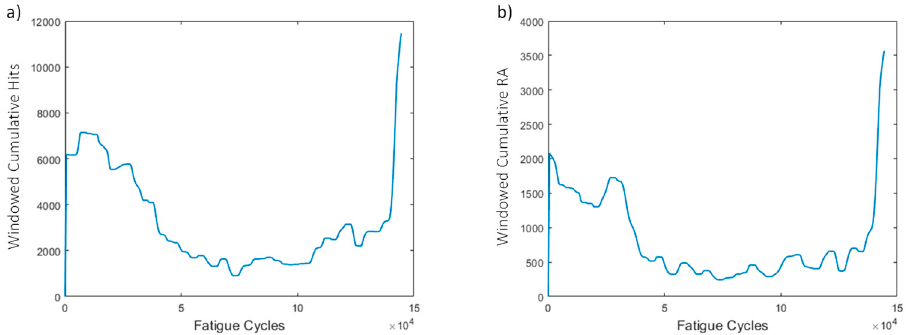
Figure 12. ( a ) Windowed cumulative hits and ( b ) RA for window size of 500 cycles for specimen CA-2.